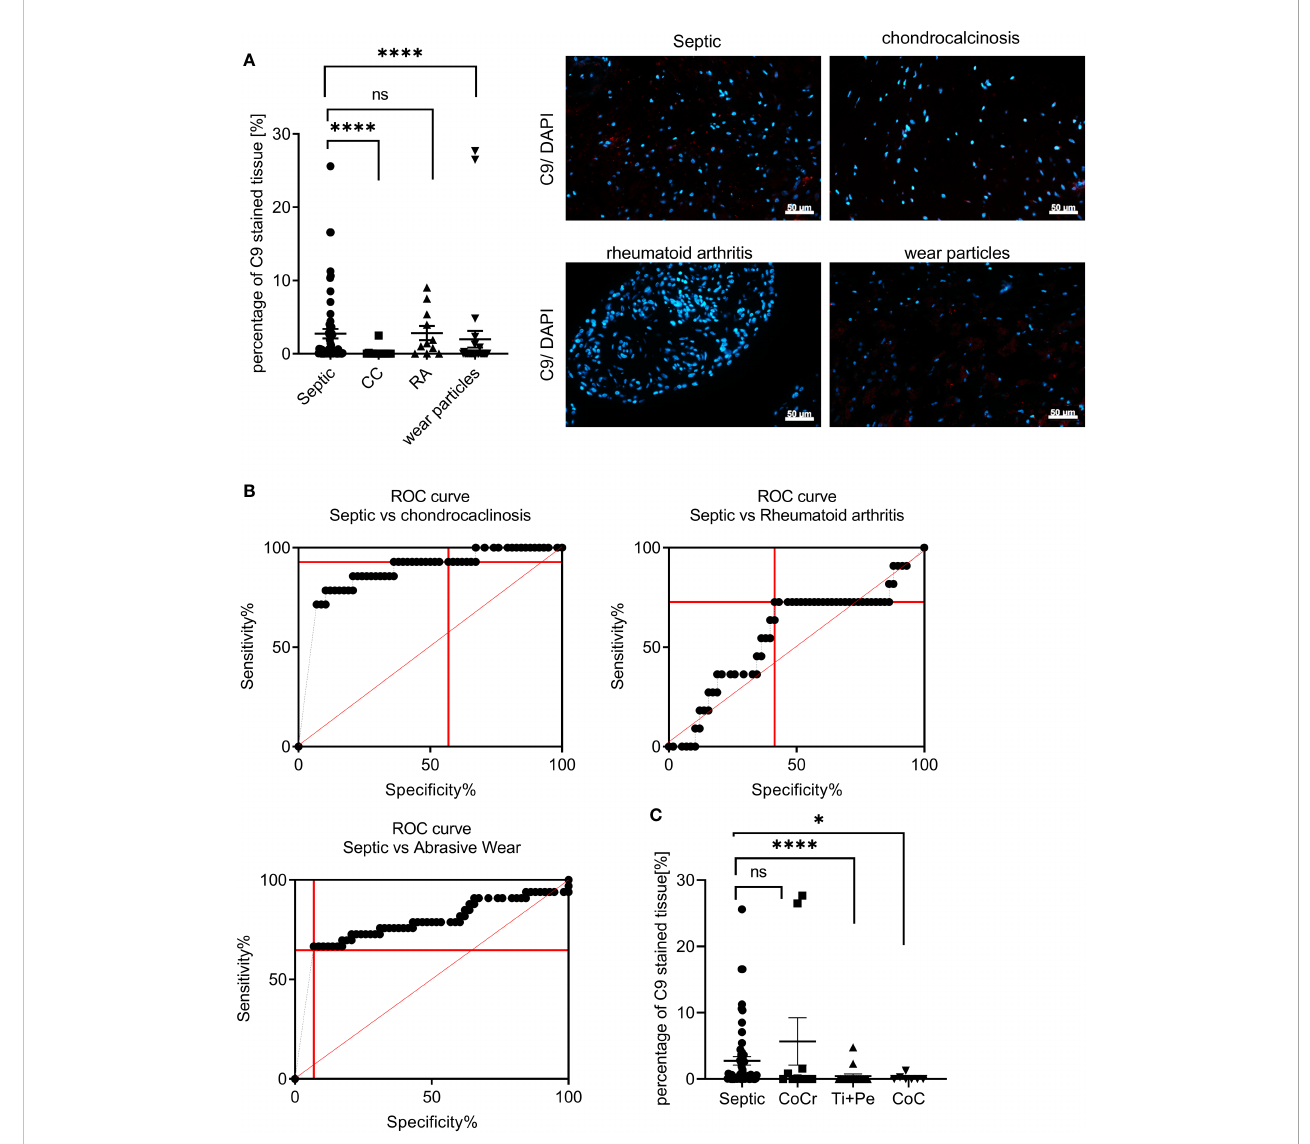
FIGURE 3 Anti-C9 immunostaining showed no cross reactivity with chondrocalcinosis and most wear particle types (A) Representative immunohistochemical stainings of periprosthetic tissue of patients with PJI (septic), chondrocalcinosis, rheumatoid arthritis and wear particles with the C9-antibody (red) are shown. The values indicate the percentage of C9 stained tissue area. Three images for each patient sample were analyzed (septic: N = 58; chondrocalcinosis: N = 14; rheumatoid arthritis: N = 11; wear particles: N = 33). White arrows indicate C9 stained tissue area. The scale bar (white bar) indicates 50 µm and pictures were taken at 400x magni fi cation. (ANOVA: post hoc , septic vs CC (p < 0.0001), septic vs wear particles (p < 0.0001), septic vs RA (p > 0.999). (B) The ROC-curve for individual percentages of C9 stained tissue area for septic and aseptic samples. Using the Youden ’ s criteria the best ratio of sensitivity to speci fi city was selected for each condition (red dashed line). The ROC-curve for septic versus CC group showed an area under the curve of 0.88. The sensitivity was 92.86% (95% of CI: 66.13% to 99.82%) while the speci fi city was 56.90% (95% of Cl: 43.23% to 69.84%).The ROC- curve for septic versus RA group showed an area under the curve of 0.56. Using the Youden ’ s criteria the best ratio of sensitivity to speci fi city was selected (red dashed line). The sensitivity was 72.73% (95% of Cl: 39.03% to 93.98%while the speci fi city was 58.62% (95% of Cl: 44.93% to 71.40%). The ROC-curve for septic versus wear particles had an AUC of 0.77. Using the Youden ’ s criteria the best ratio of sensitivity to speci fi city was selected (red dashed line). The sensitivity was 64.71% (95% of Cl: 46.49% to 80.25%while the speci fi city was 93.1% (95% of Cl: 83,27% to 98,09%). (C) Representative immunohistochemical staining of the C9-antibody (red) in periprosthetic tissue of patients with PJI (septic) or various wear types can be seen. The values indicate the percentage of C9 stained tissue (septic: N = 58; CoCr: N = 10; Ti+PE: N = 16; CoC: N = 7). Three images for each patient sample were analyzed. White arrows indicate C9 stained tissue area. The scale bar (white bars) indicates 50 µm and pictures were taken at 400 x magni fi cation. (ANOVA: post hoc ). *p < 0.05, ****p <